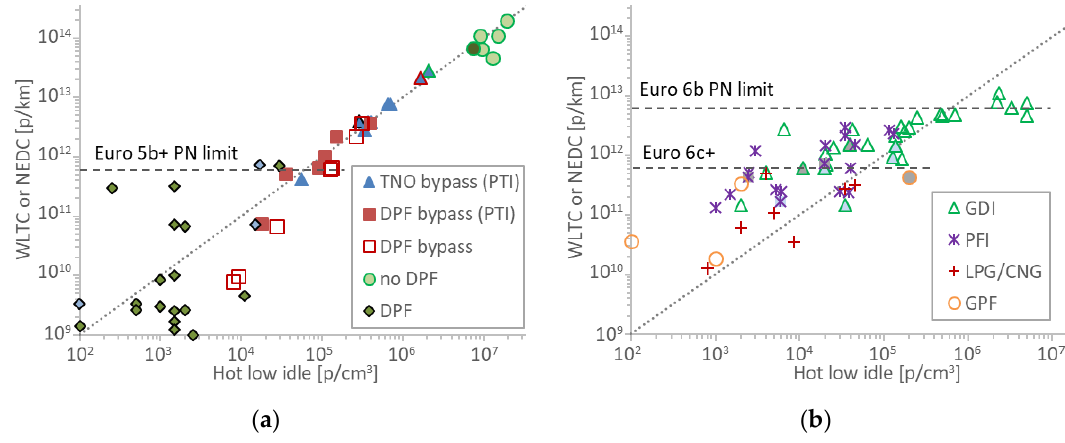
Figure 3. Scatter plots of hot idle concentrations with WLTC (Worldwide harmonized Light vehicles Test Cycle) or NEDC (New European Driving Cycle) type approval test cycles emissions at TNO or JRC (rest points): ( a ) compression ignition vehicles; ( b ) positive ignition vehicles. Each point is a vehicle. Hybrids have grey background. Vehicles with start and stop have light blue background. Horizontal lines give the respective Particle Number (PN) limits. CNG = Compressed Natural Gas; DPF = Diesel Particulate Filter; GDI = Gasoline Direct injection; GPF = Gasoline Particulate Filter; LPG = Liquefied Petroleum Gas; PFI = Port Fuel Injection; PTI = Periodical Technical Inspection; PTI = Periodical Technical Inspection.